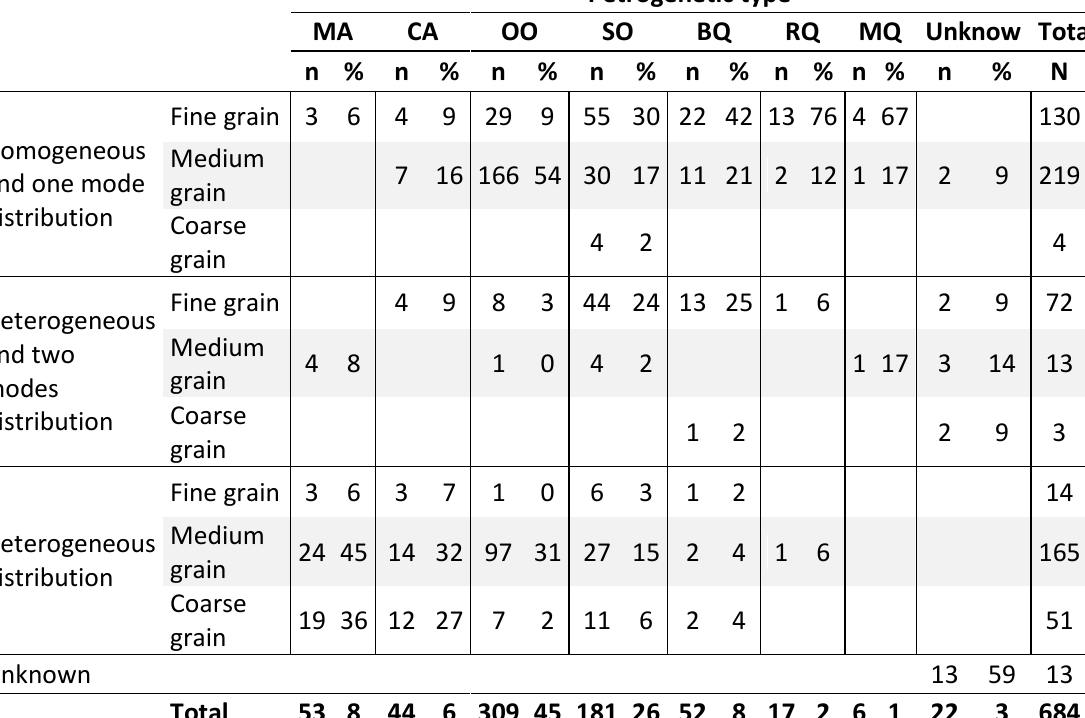
Table 3. Frequency table of petrological features identified in El Esquilleu Level-XXIIR based on binocular characterisation. Columns are petrogenetic types and rows contain the characteristics of grains according to size, classified by distribution and size itself. Percentage inner columns represent the proportion of determined quartz grain size variety regarding each type. Percentages in the total raw refer to the percentage of each type in the full